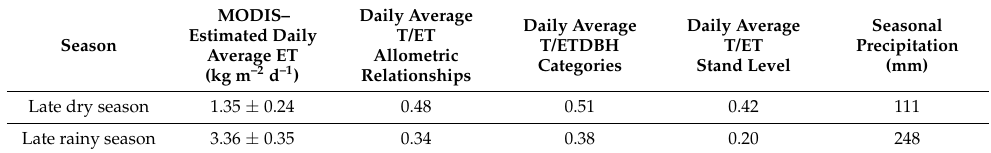
Table 4. Estimated ET (kg m –2 d –1 ) using the MOD16–ET T/ET ratio in the El Palmar tropical dry deciduous forest using allometric relationships, DBH categories (T DBH ), and stand-level transpiration. The late dry season corresponds to March–April; the late rainy season, to September–October 2019.